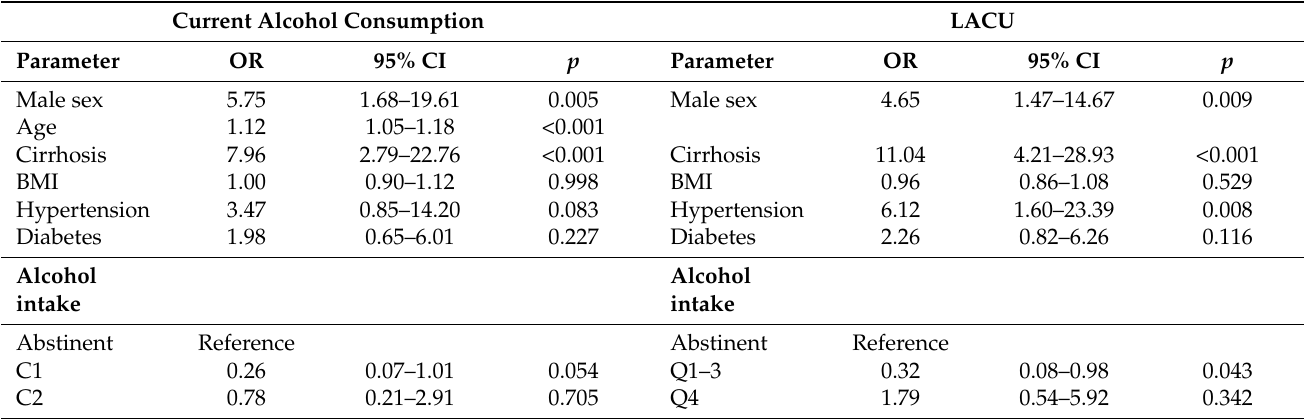
Table 8. Multivariate analysis of parameters associated with hepatocellular carcinoma (HCC).